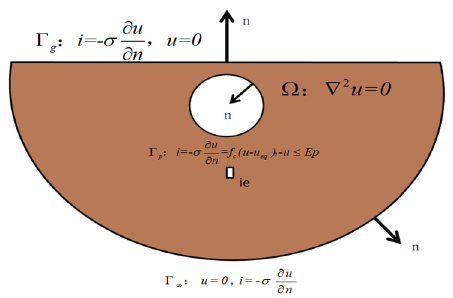
Figure 7. Schematic diagram of buried pipeline boundary.